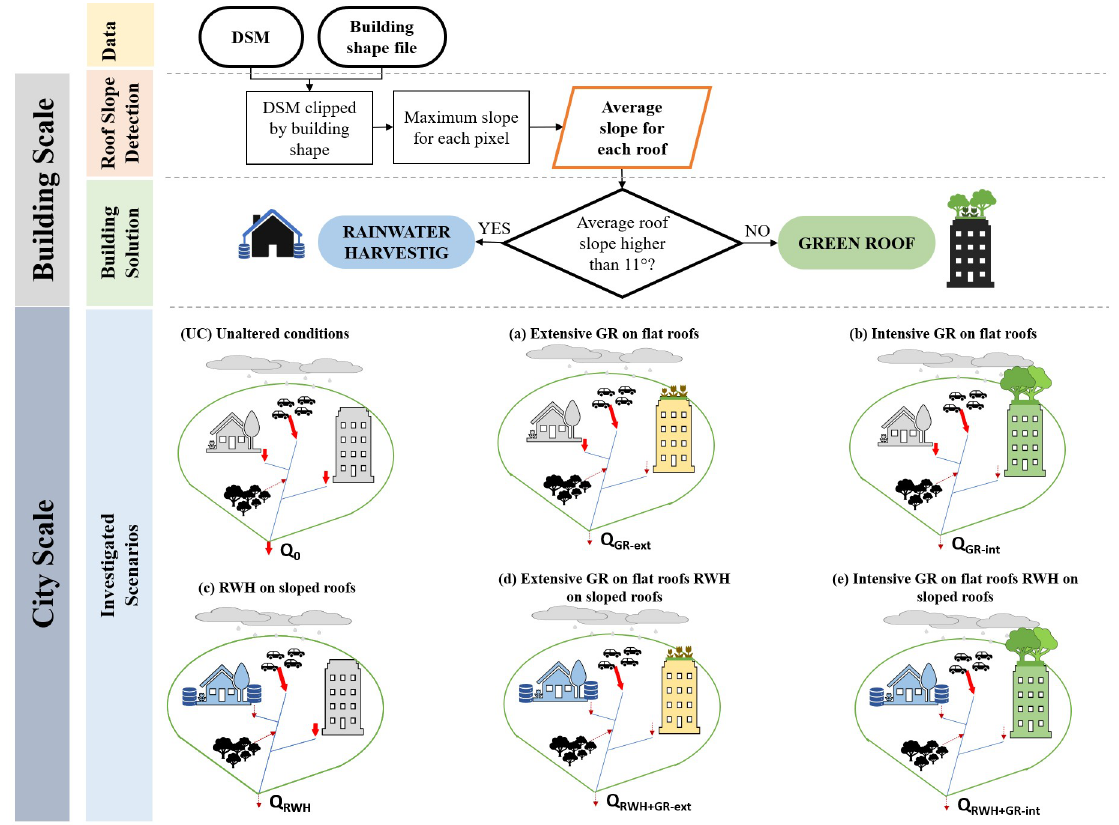
Fig 1. Schematic representation of the methodology used in this work to select the mitigation strategy to implement (GR or RWH, as a function of roof slope) and the analysed scenarios. The selection of the mitigation solution to install is done at “Building scale”, i.e. evaluating each building separately. The analysis of the discharge reduction for the different scenarios is developed at “City scale”, i.e. investigating the effects for an extended urban area, which can be a city or a large neighbourhood.